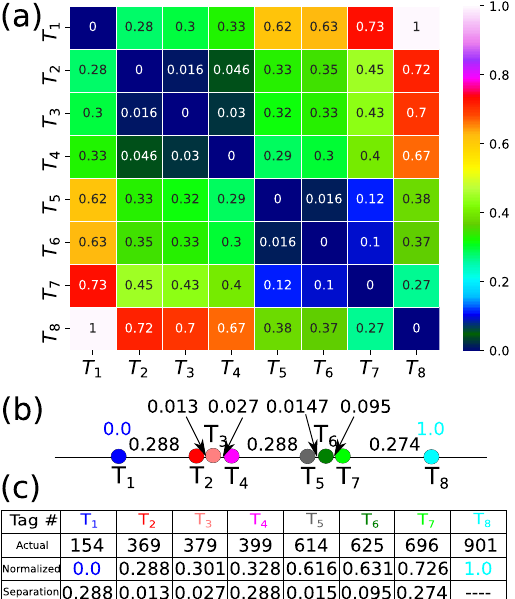
Figure 4. ( a ) Heat map of the normalized tag time delay ( ˜ �τ) mn = (�τ) mn /(�τ) 18 for m = 1, 8 and n = 1, 8 . ( b ) Inter tag spacing in the normalized unit where d 18 = 1.0 . The normalized tag time delays are proportional to the normalized spacing distances validate the accuracy of Method I. ( c ) Table contains the actual tag positions and normalized inter-spacing